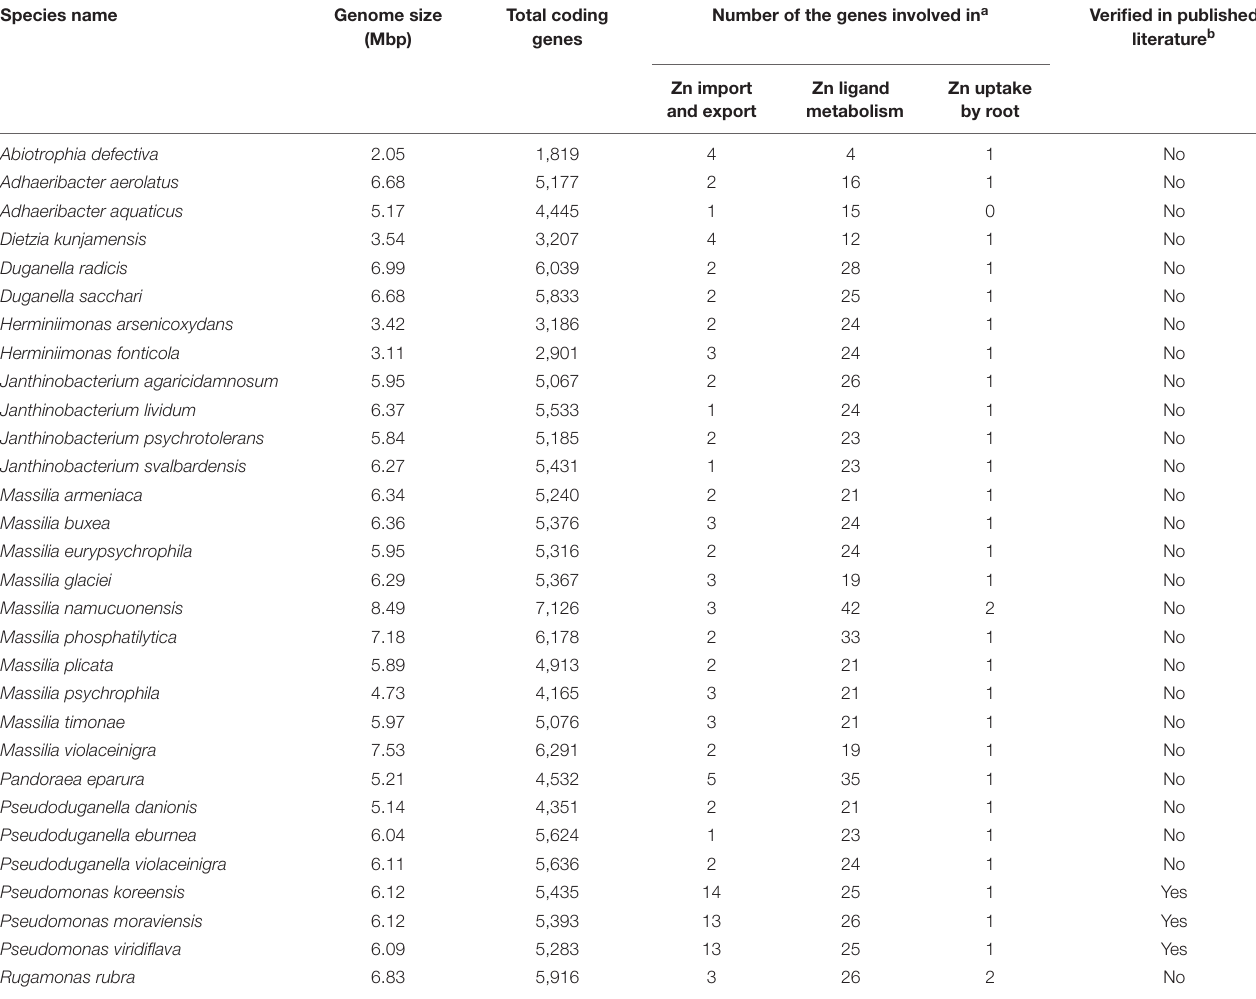
TABLE 2 | Functional statistics of the potential soil Zn-mobilizing microbes enriched in wheat rhizosphere. Species